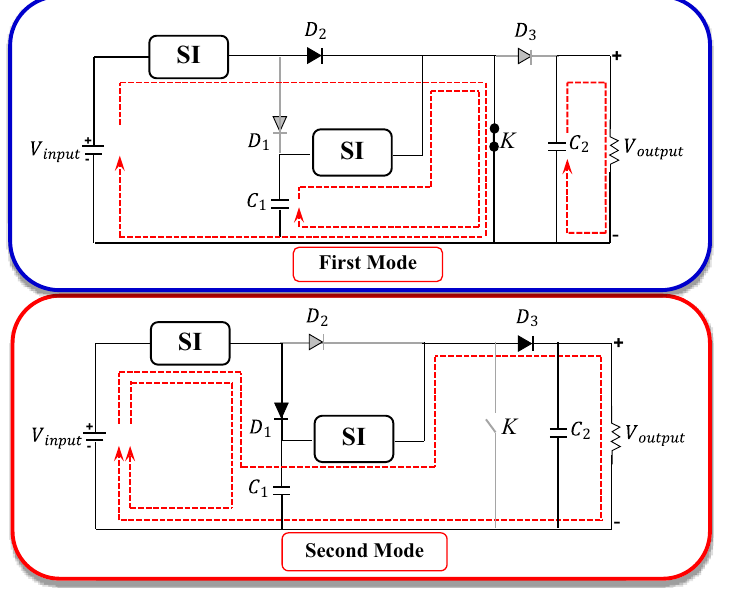
Figure 4. The SIBCM operation